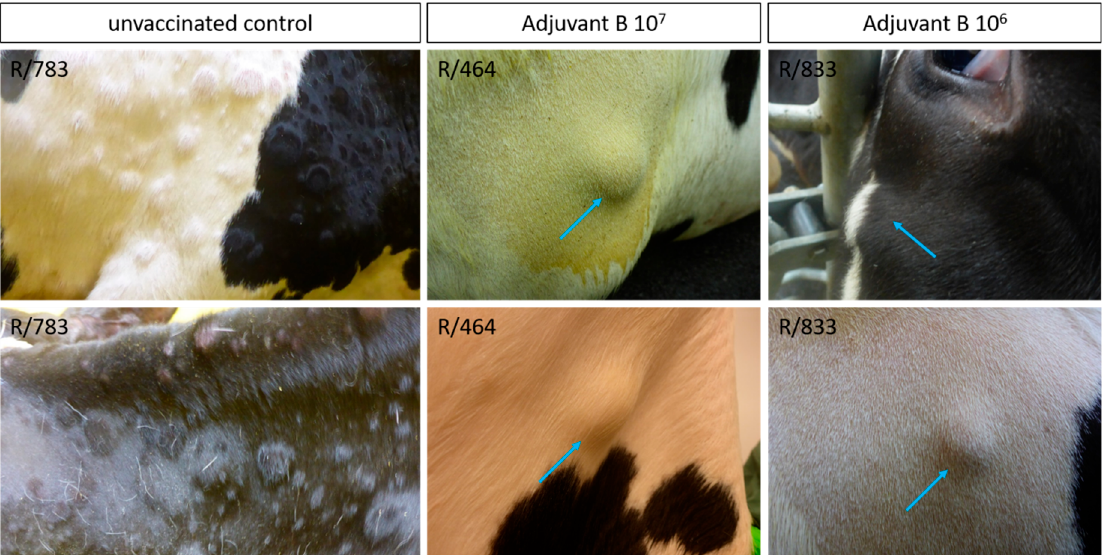
Figure 9. Comparison of skin nodules observed after challenge infection during the vaccine-efficacy study. After challenge infection, skin alterations occurred in some cattle previously immunized with Adjuvant B-containing vaccine. Although affected cattle of the challenge control group showed skin lesions typical for LSDV (e.g., R/783), skin alterations in cattle previously vaccinated with Adjuvant B 10 7 (e.g., R/464) and Adjuvant B 10 6 (e.g., R/833), respectively, were clearly different in shape and appearance (blue arrows).